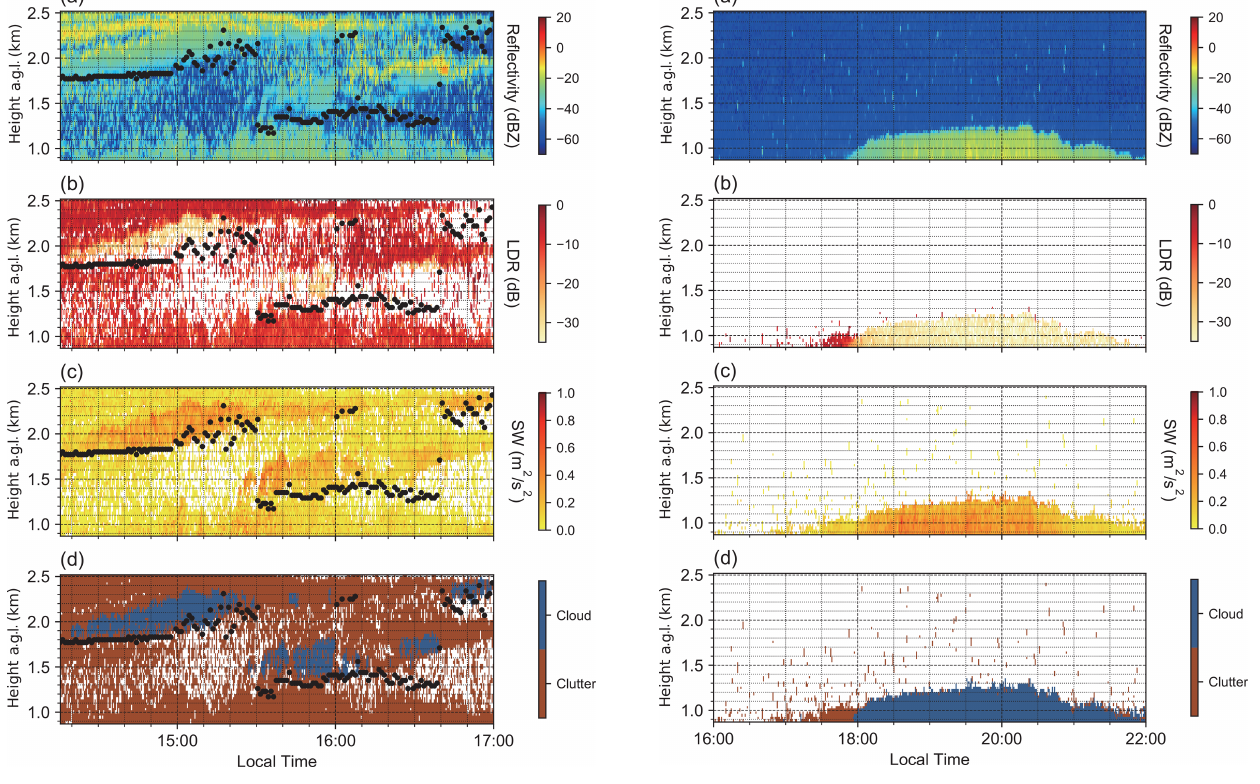
Figure 12. Same as Fig. 8 but for 14:15 to 17:00LT on 19 August 2013.